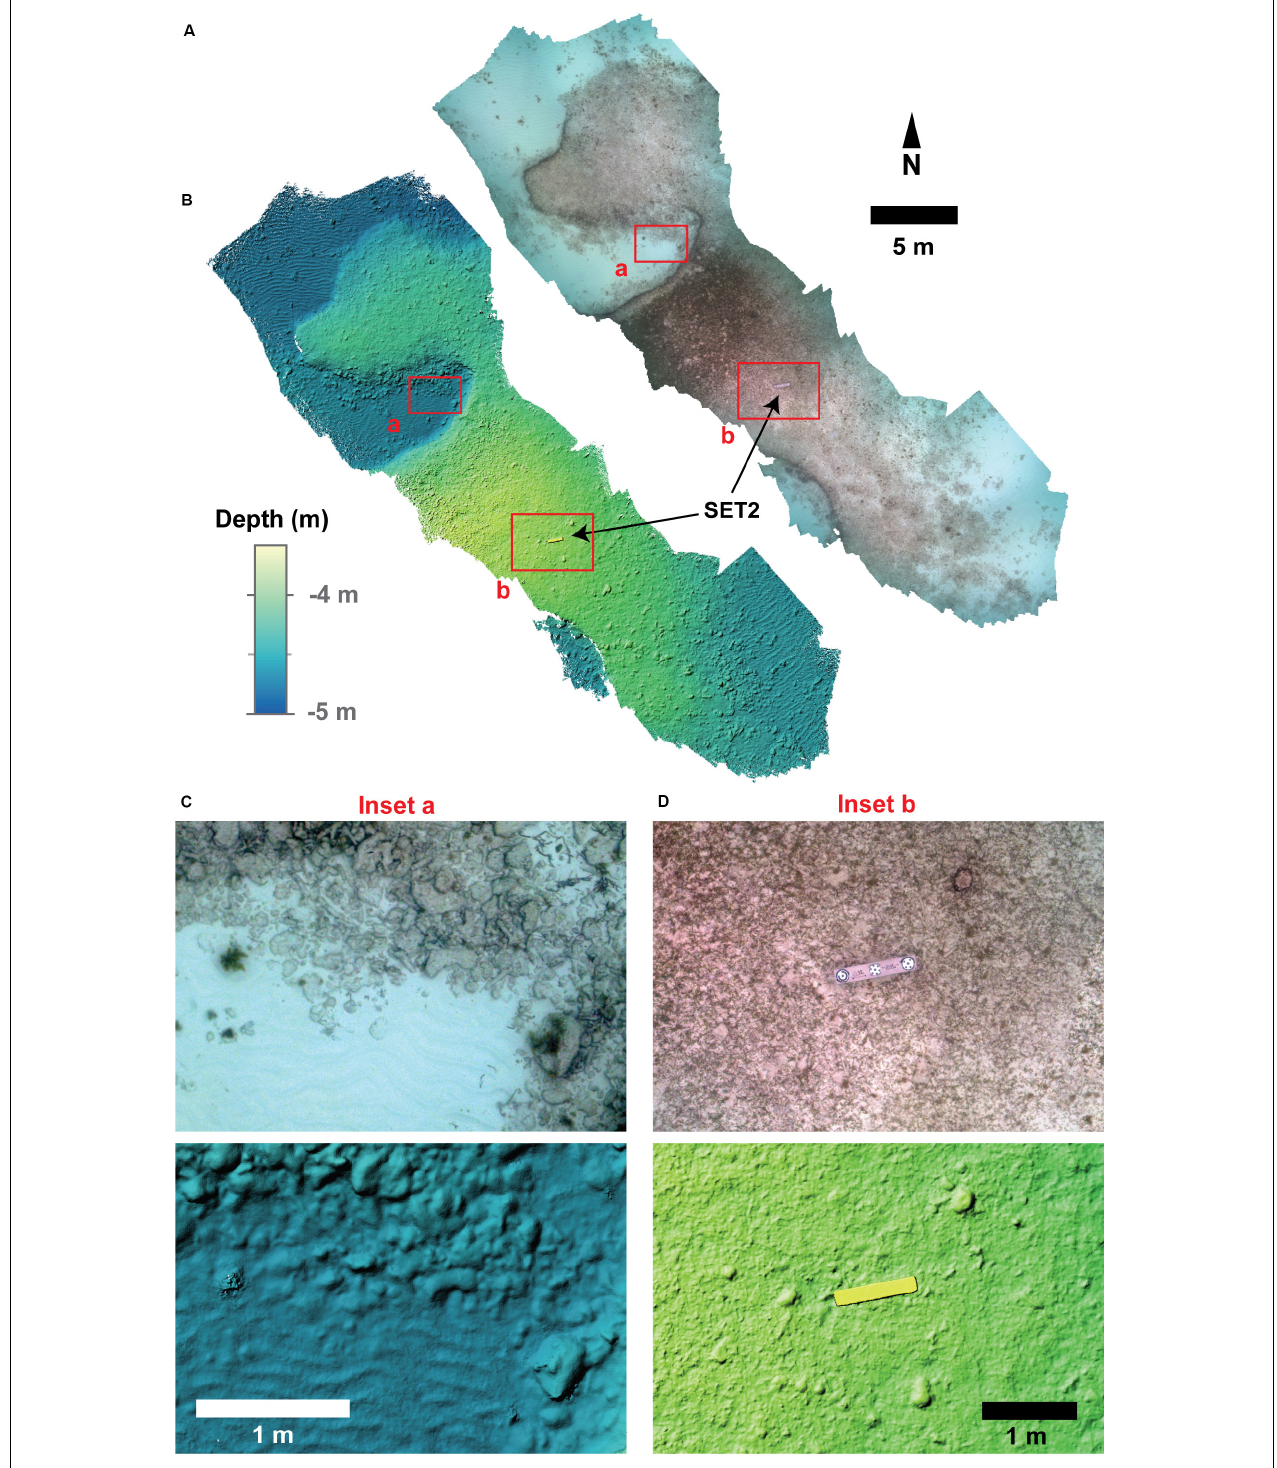
FIGURE 5 | (A,B) Mapped orthomosaic and bathymetry obtained from three survey passes of the Surface Elevation Table (SET) station 2 site with the SQUID-5 system. The shaded relief bathymetry is shown for a digital surface model (DSM) derived from the Structure-from-Motion (SfM) dense point cloud. The spatial resolution of the photo mosaic and DSM are 2.1 mm and 4.1 mm, respectively. (C,D) Highlights of the benthic maps of the site, including sand, rubble, eelgrass and the scale bar mounted on the SET station 2 monument.